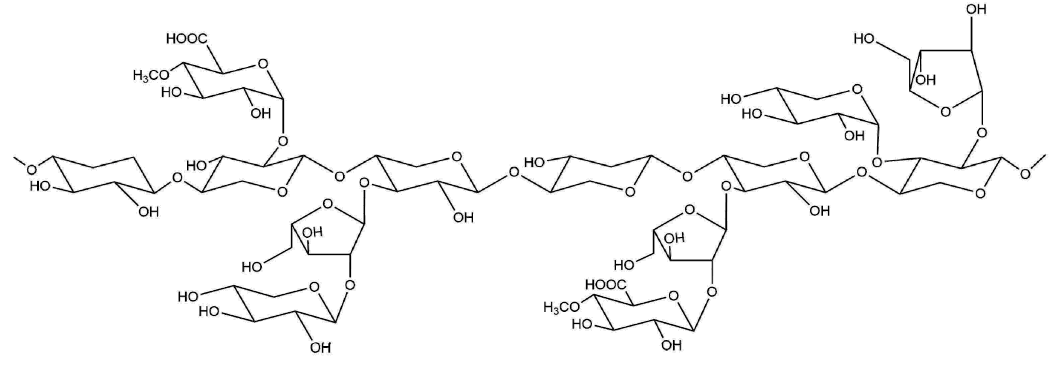
Figure 3. Chemical structure of arabinoxylan.